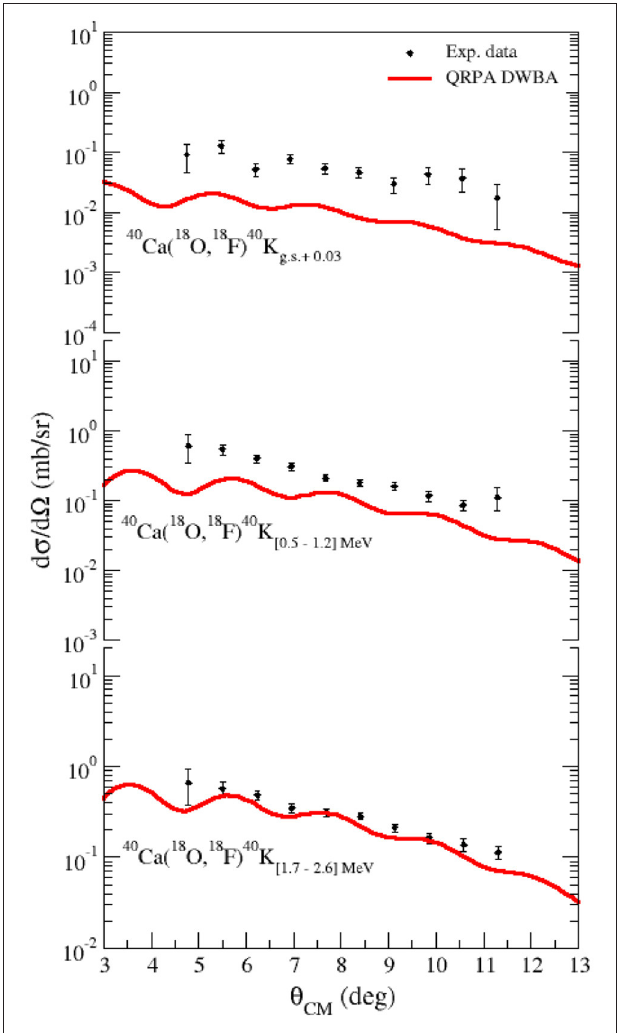
FIGURE 4 | Angular distributions for the 40 Ca( 18 O, 18 F) 40 K transitions corresponding to the three selected regions in the single charge exchange (SCE) spectrum sketched in Figure 3 . The red curves are the sum of the cross sections associated to the different transitions belonging to the three regions resulting from the quasi-particle random phase approximation (QRPA) DWBA calculations.